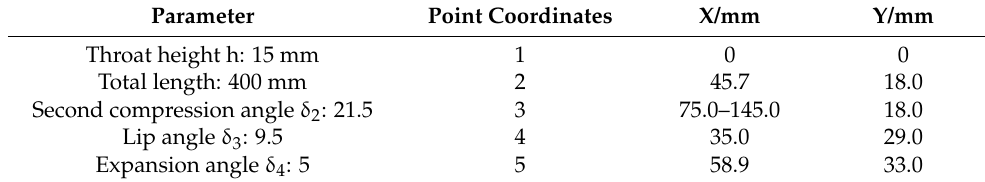
Figure 2. Intake model and pressure measuring point positions. Table 2. Dimensions of the intake.